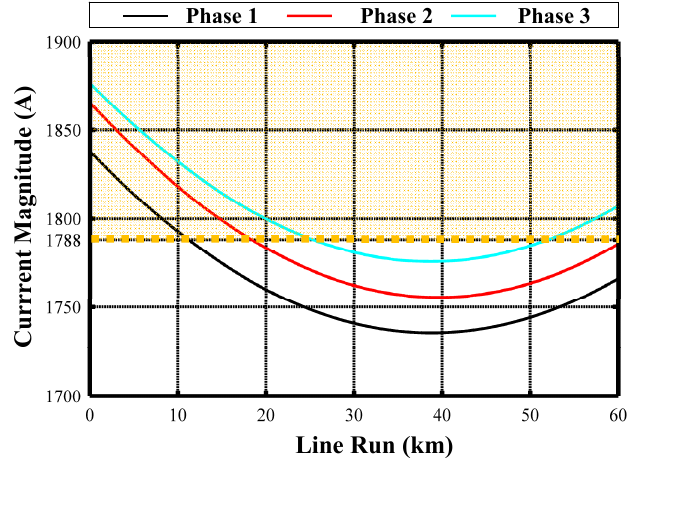
Figure 17. Phase current magnitudes along the compensated single-circuit cable in CB without PTs and compensated only at the two ends (as in Figure